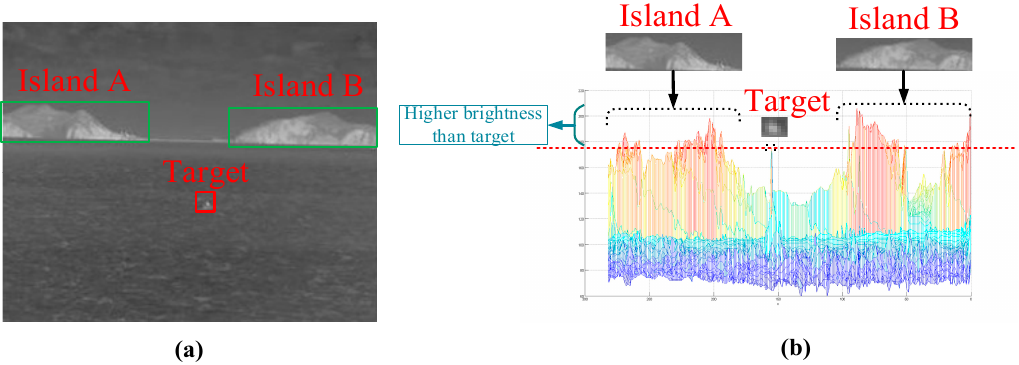
Figure 2. Infrared maritime image including island and target. ( a ) denotes the original image, ( b ) denotes the gray distribution of each area.